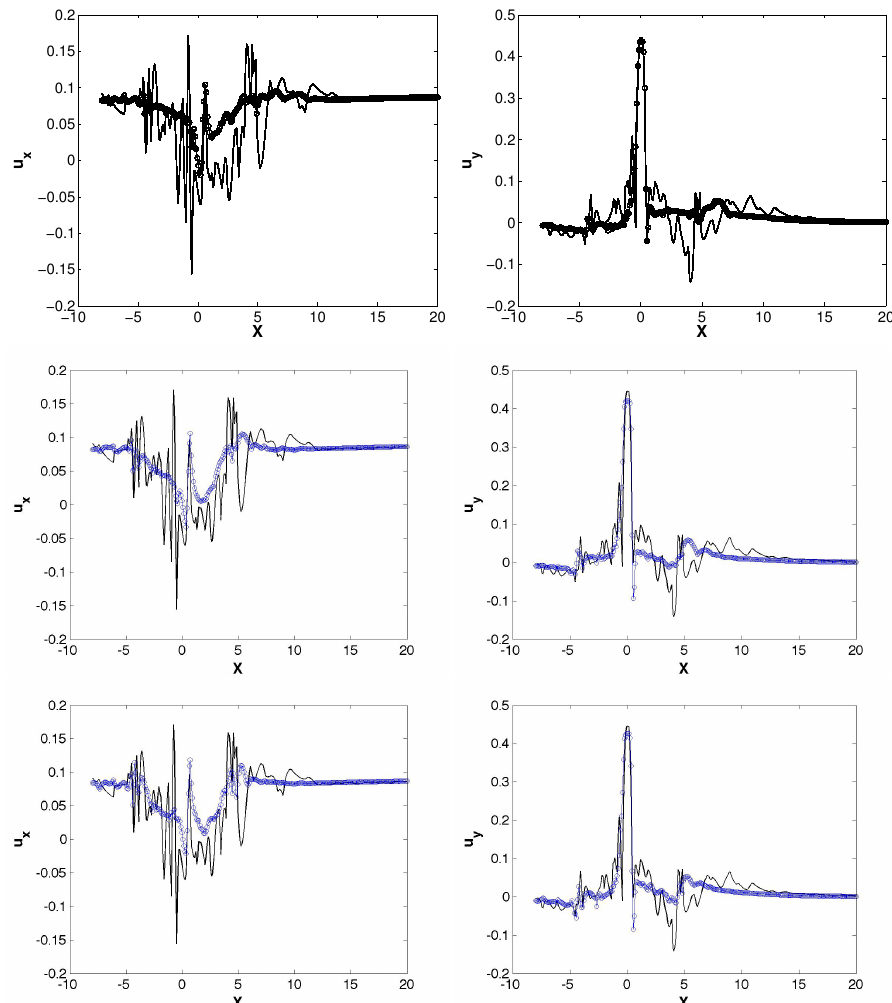
Figure 12. Counterpart of Figure 7 in the three-blades turbine applying HODMD in 196 snapshots starting at time 80.1s. Data extracted at y = 2